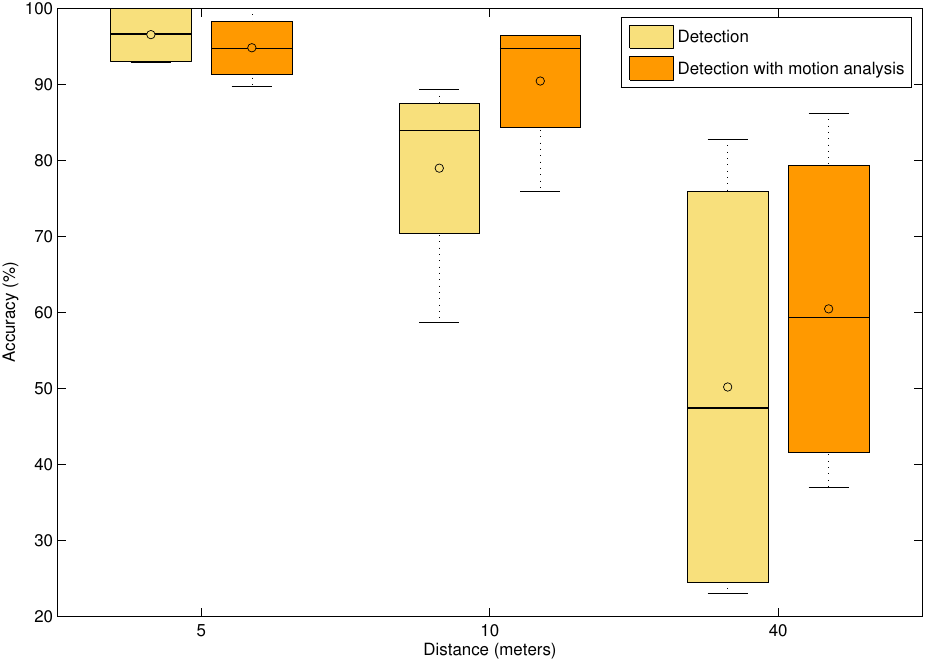
Figure 7. Laser spot detection accuracy for the mCHT-based detector (yellow boxplots) and for the mCHT-based detector and motion pattern analysis (orange boxplots) for linebreak different distances.